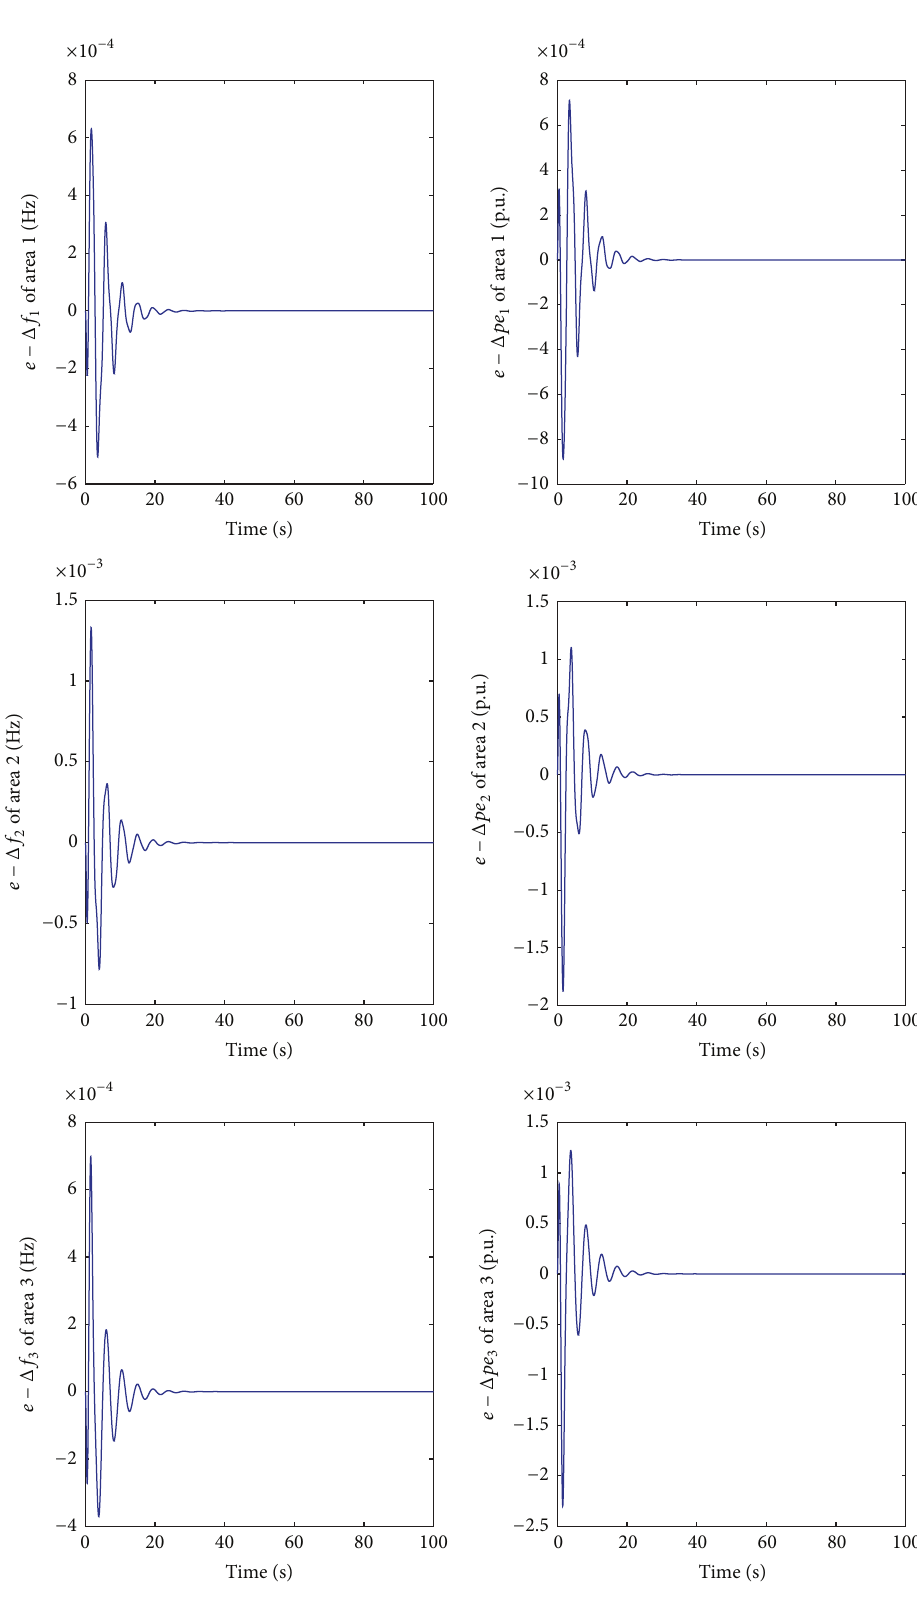
Figure 6: Observation errors of the original subsystems and the newly added